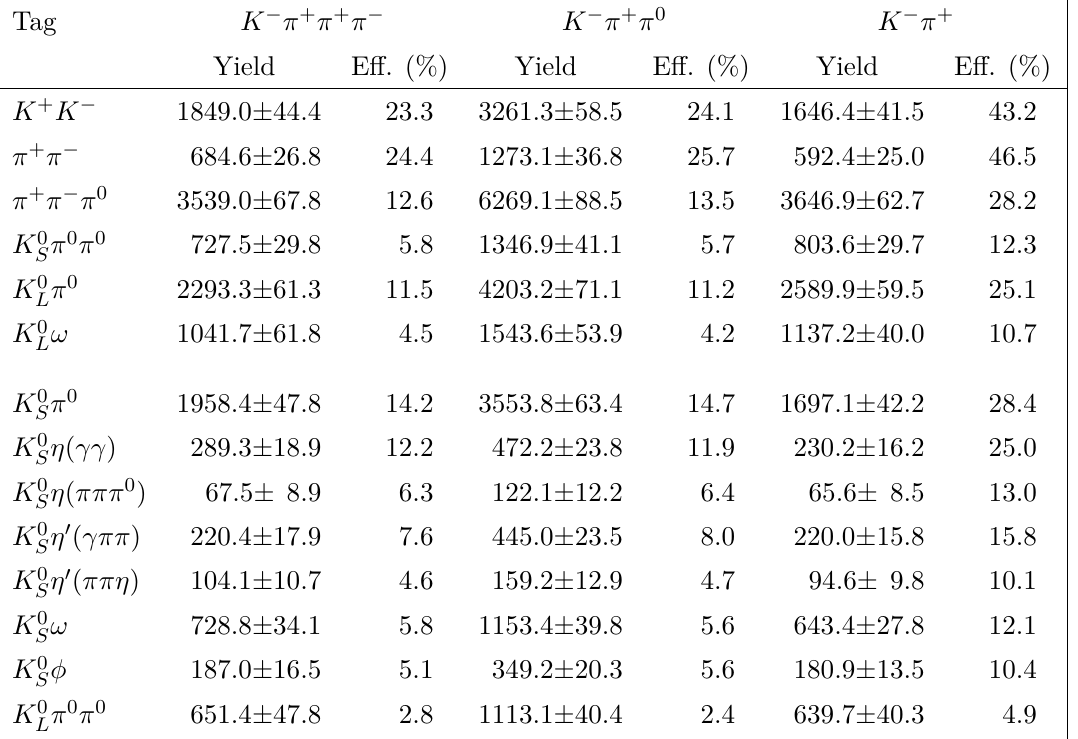
Table 3 . Signal yields for the CP -tagged events. The uncertainties are statistical only. Also shown are the selection efficiencies as determined from Monte Carlo simulation, all of which have a statistical uncertainty of 0 . 1% or